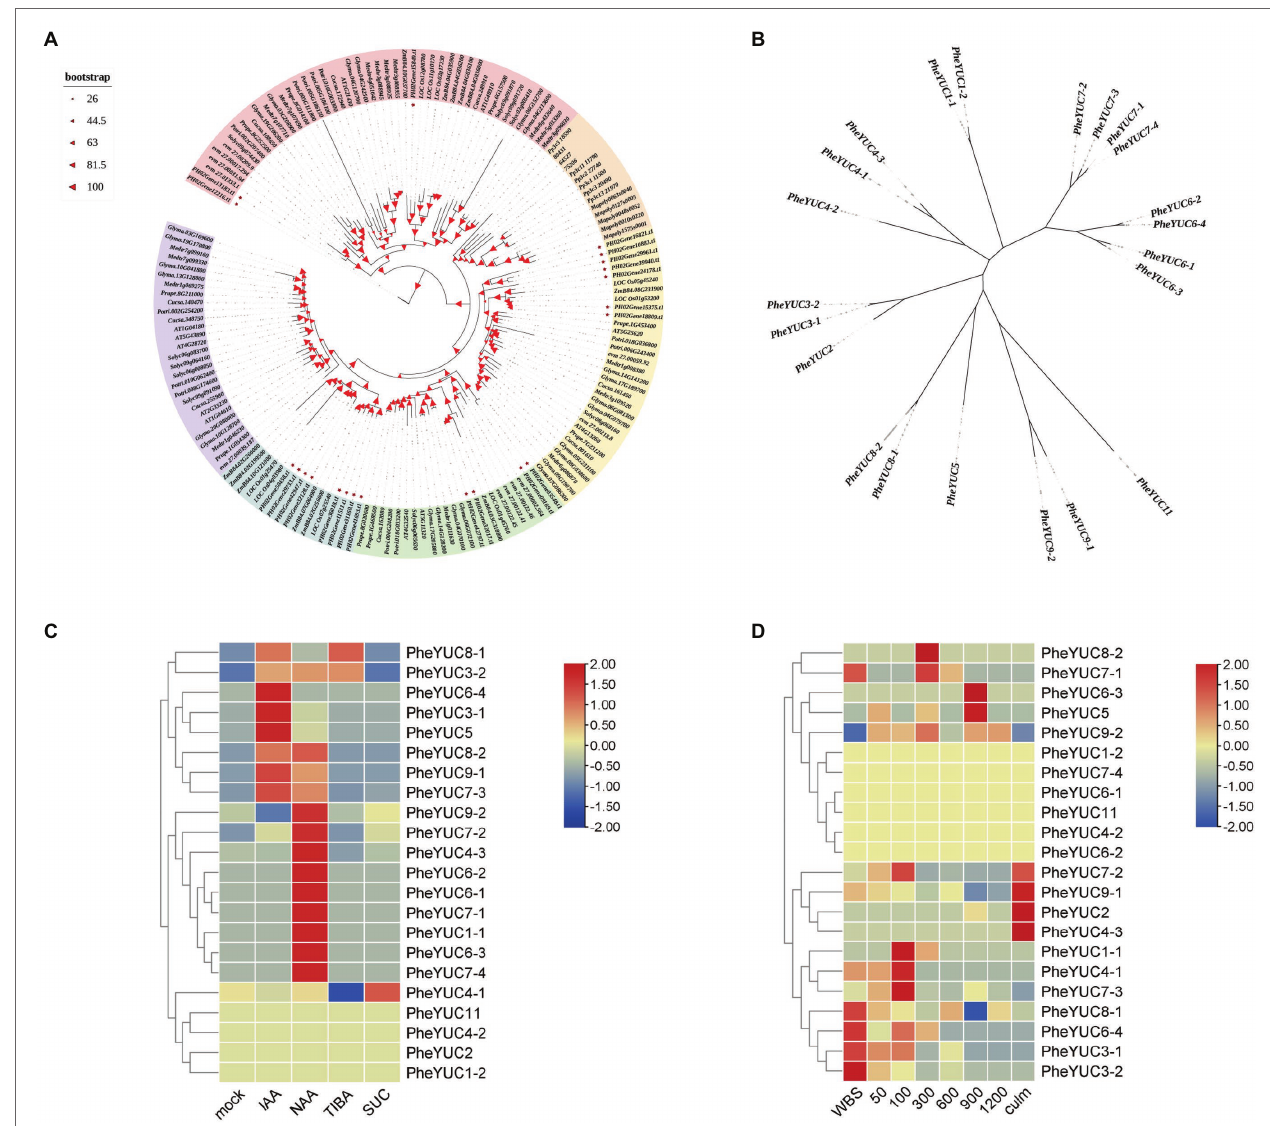
FIGURE 4 | Phylogenetic tree and expression pattern analysis of YUCCA genes family. (A) Phylogenetic tree of 160 YUCCA genes of 14 species. Phe Phyllostachys edulis , AT Arabidopsis thaliana , Os Oryza sativa , evm Amborella trichopoda , Cucsa Cucumis sativus , Glyma Glycine max , Mapoly Marchantia polymorpha , Medtr Medicago truncatula , Pp Physcomitrella patens , Prupe Prunus persica , Potri Populus trichocarpa , Number Selaginella moellendorffii , Solyc Solanum lycopersicum , and Zm Zea mays . (B) Individual phylogenetic tree of 22 members of the moso bamboo YUCCA gene family. All genes were renamed with rice homology. Correspondence is shown in Supplementary Table S3 . All trees are unrooted trees, and branch lengths represent only sequence differences. (C,D) Expression of different treatments and different growth stages (IAA Indole-3-acetic acid, NAA Naphthaleneacetic acid, TIBA